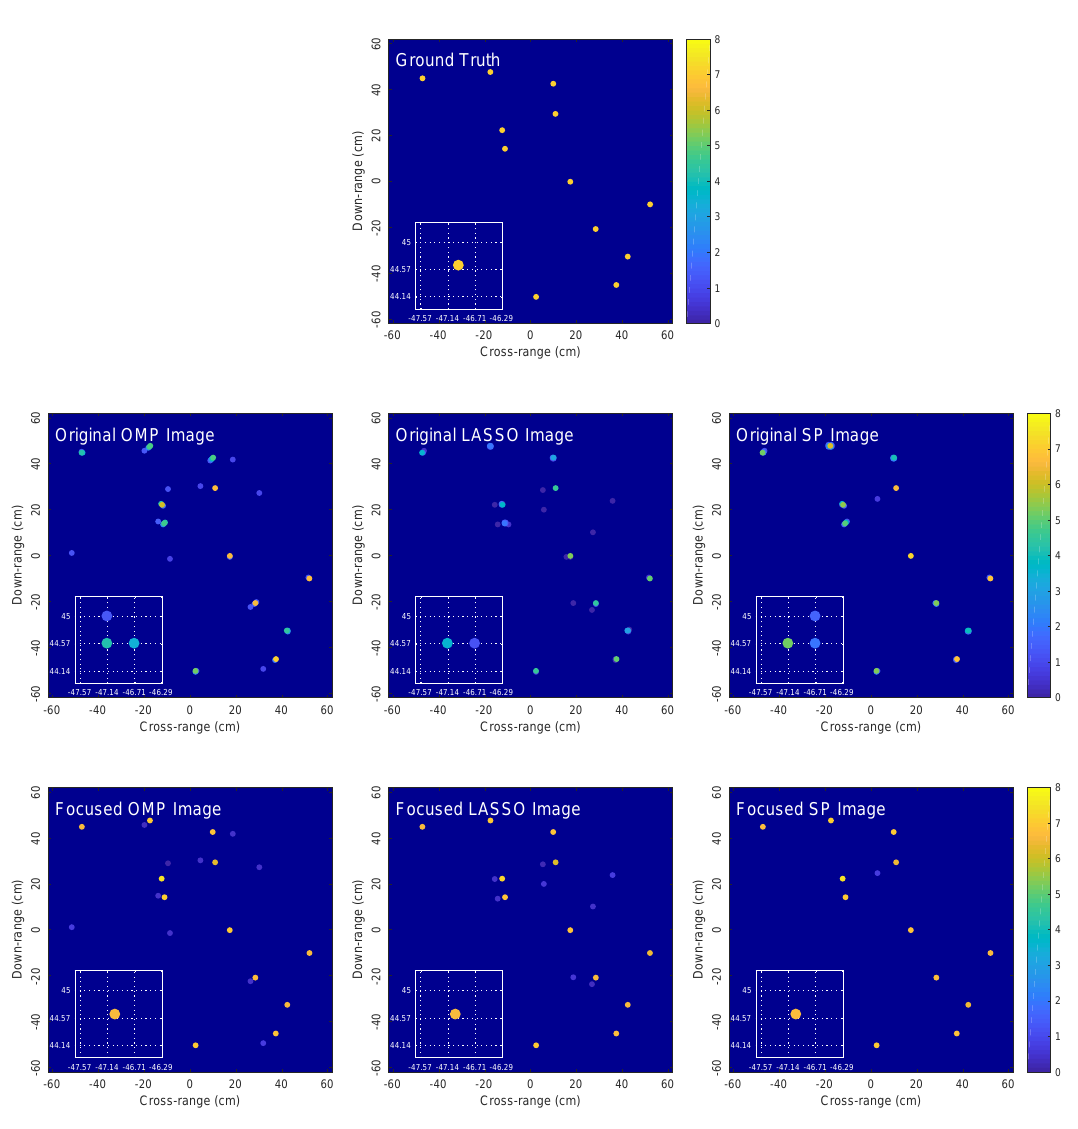
Figure 8. Comparison of the original OMP, LASSO and SP images and the corresponding focused images obtained by the proposed algorithm for a non-centrosymmetric target with 12 randomly-located scatterers. In the zoomed-in images, dictionary grid points are located at intersections of dotted